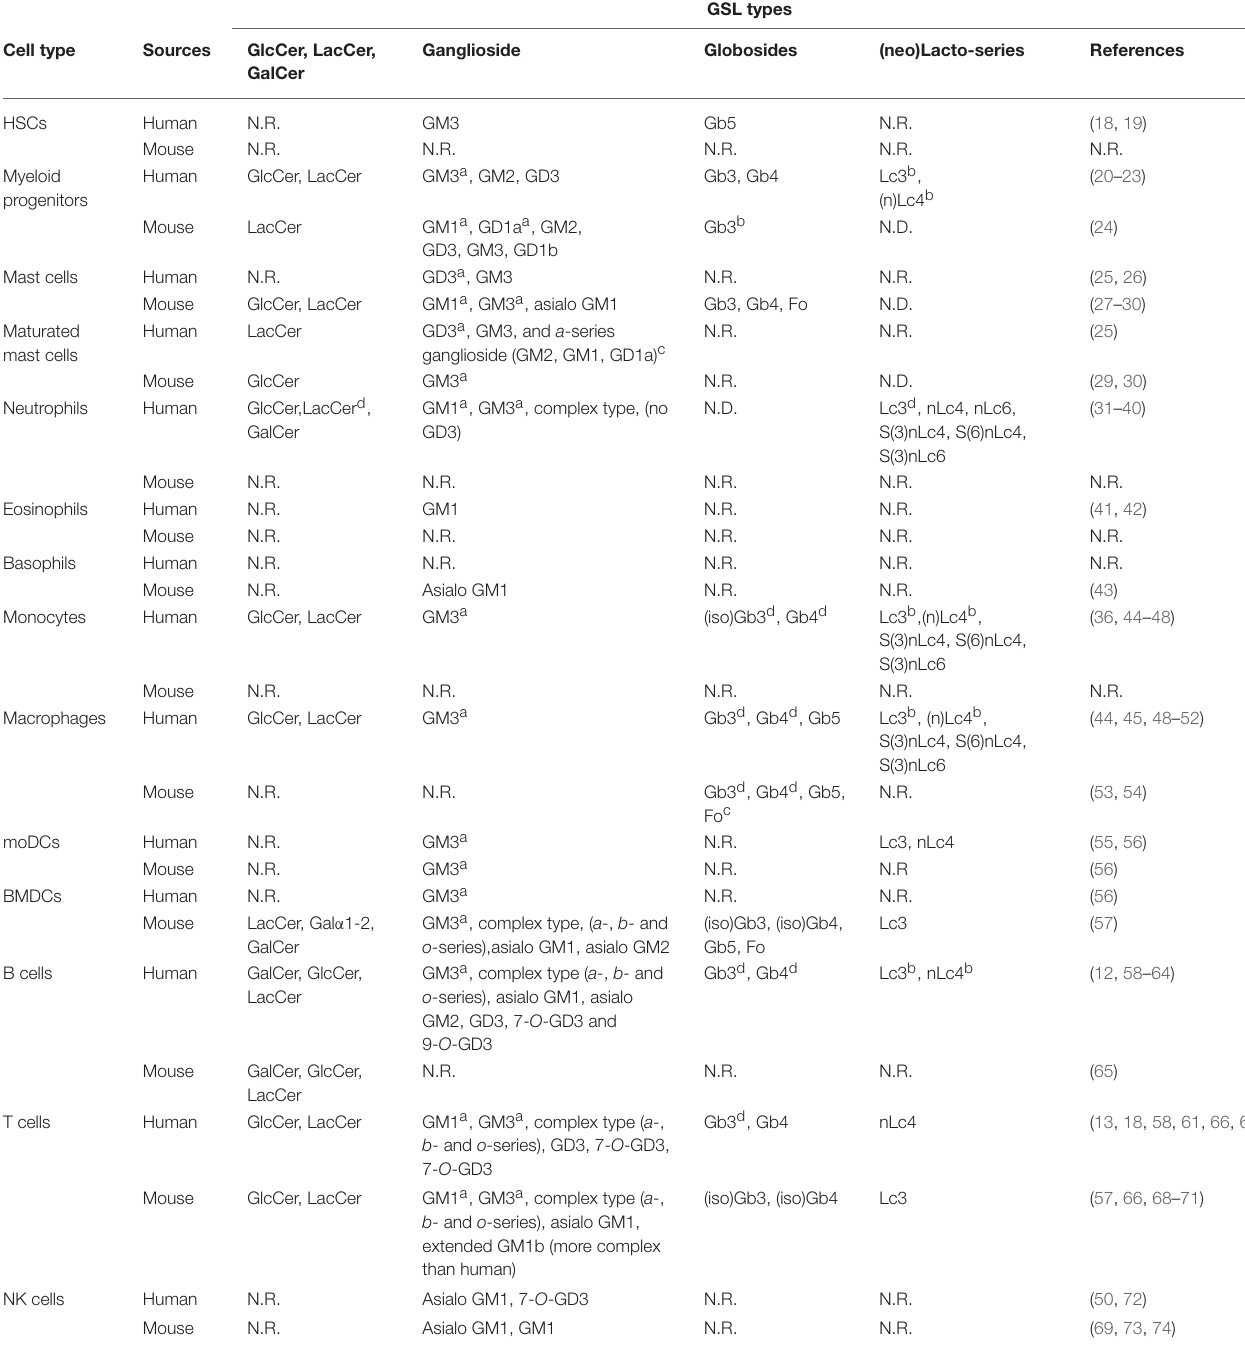
TABLE 1 | GSL expression in human and murine immune